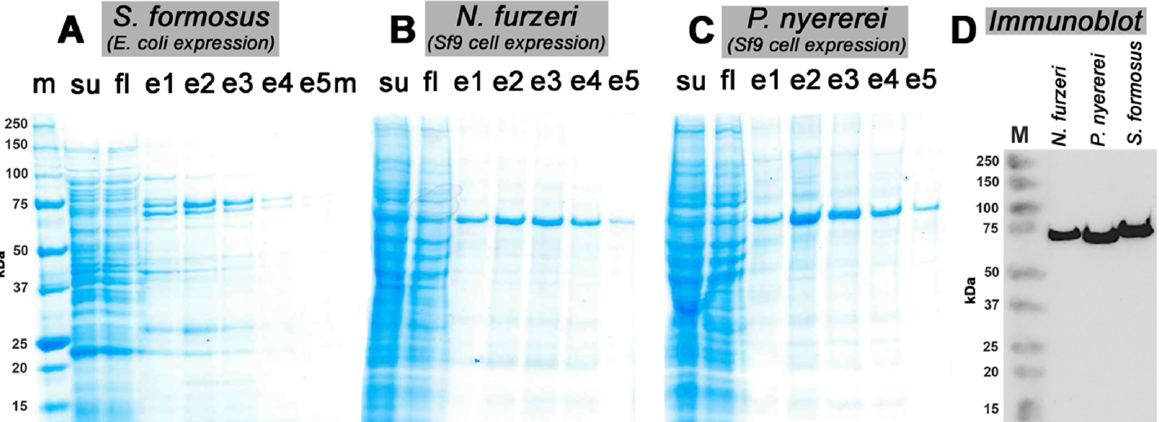
Figure 1. Recombinant expression and purification of bony fish ALOX isoforms. The putative bony fish ALOX15 orthologs coding regions were expressed as recombinant N-terminal his-tag fusion proteins in either E. coli (S. fomosus) or in Sf9 insect cells ( N. furzeri, P. nyererei ) and cellular lysates were prepared. Aliquots of the lysate supernatants were mixed with preconditioned Ni-NTA agarose and the recombinant his-tag fusion proteins were eluted (see Section 4). Elution fractions e1–e5 (0.2 mL each) were collected and aliquots were analyzed by SDS-PAGE. ALOX containing elution fractions were pooled and aliquots were analyzed by Western blotting using an anti-his-tag antibody. (m) Molecular weight markers, (su) Cellular lysate supernatants. (fl) Chromatographic flowthrough. ( A ) SDS-PAGE of the elution fractions of the ALOX isoform of S. formosus ( E. coli expression). ( B ) SDS-PAGE of the elution fractions of the ALOX isoform of N. furzeri (Sf9 cell expression). ( C ) SDS-PAGE of the elution fractions of the ALOX isoform of P. nyererei (Sf9 cells expression). ( D ) ALOX containing elution fractions were pooled and aliquots of these pools were analyzed by immunoblotting using an anti-his-tag antibody.